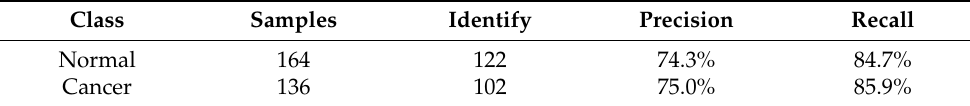
Table 3. Traditional CNN model test